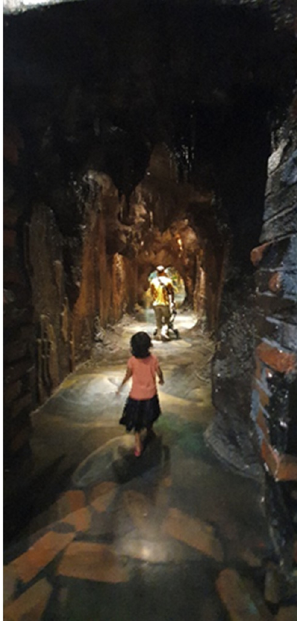
Figure 6: The installation of Goa Selarong in Museum Mandala Bhakti.